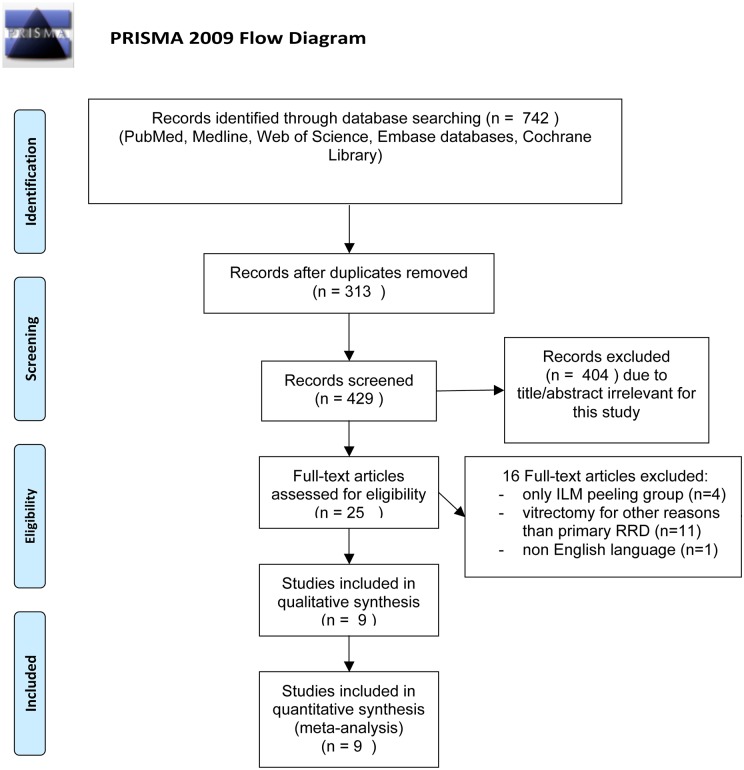
Flow diagram of the study selection process.From: Moher D, Liberati A, Tetzlaff J, Altman DG, The PRISMA Group (2009). Preferred Reporting Items for Systematic Reviews and Meta-Analyses: The PRISMA Statement. PLoS Med 6(7): e1000097. doi: 10.1371/journal.pmed1000097
For more information, visit
www.prisma-statement.org.